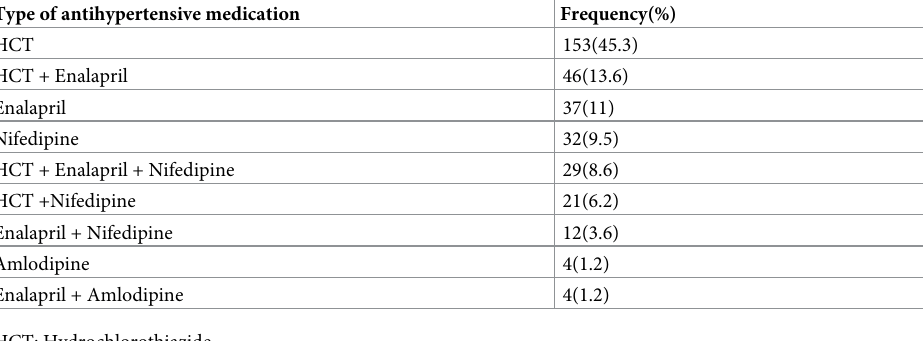
Table 2. Type of antihypertensive medications and regimens used among adult ambulatory hypertensive patients in Mekelle Hospital,